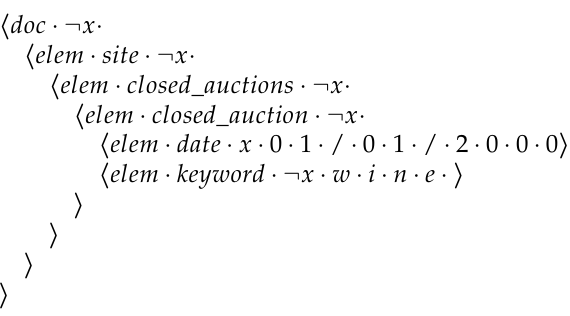
Figure 4. The nested word of the x -marked X ML document from Figure 2.